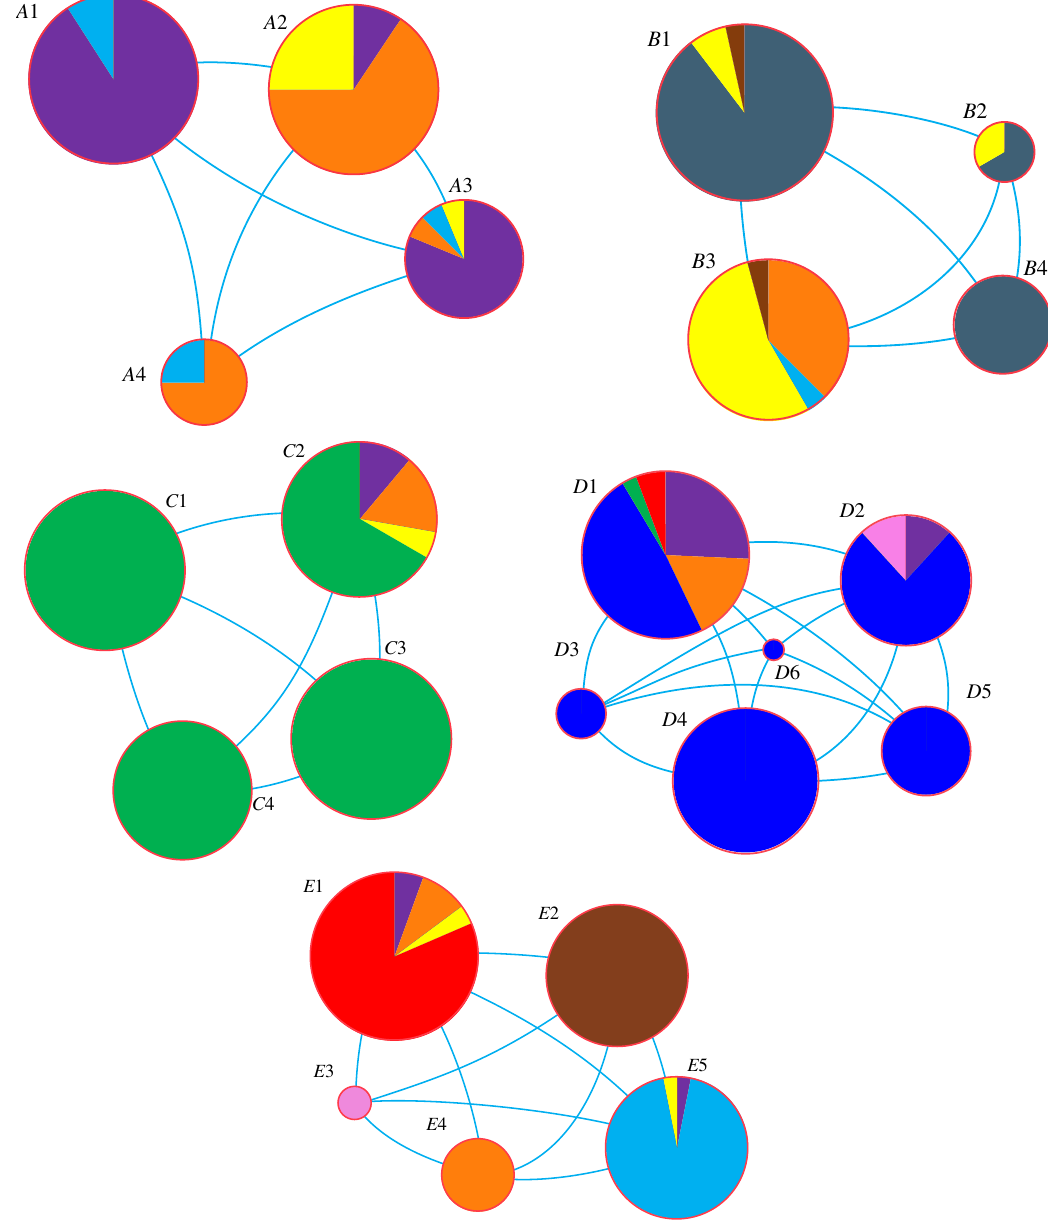
FIG. 11. Our multiresolution community detection method resolves the subcommunity structure of the five communities of the S&P 500 (see Fig. 7). Community A mainly comprises Consumer Discretionary and Industrial stocks, B all the Energy stocks, C all the Finance stocks, and D all the IT stocks, while E is highly heterogeneous but very well resolved into five separate subcommunities mainly comprising Utilities, Industrial, Health Care, Telecommunication Services, and Consumer Staples stocks, respectively. Besides this relatively predictable partition, we note that Industrials stocks, and to a lesser extent also Materials and Consumer Discretionary stocks, are quite dispersed across different communities. (From cross-correlations of log-returns of daily closing prices from 2001Q4 to 2011Q3; the Louvain algorithm has been